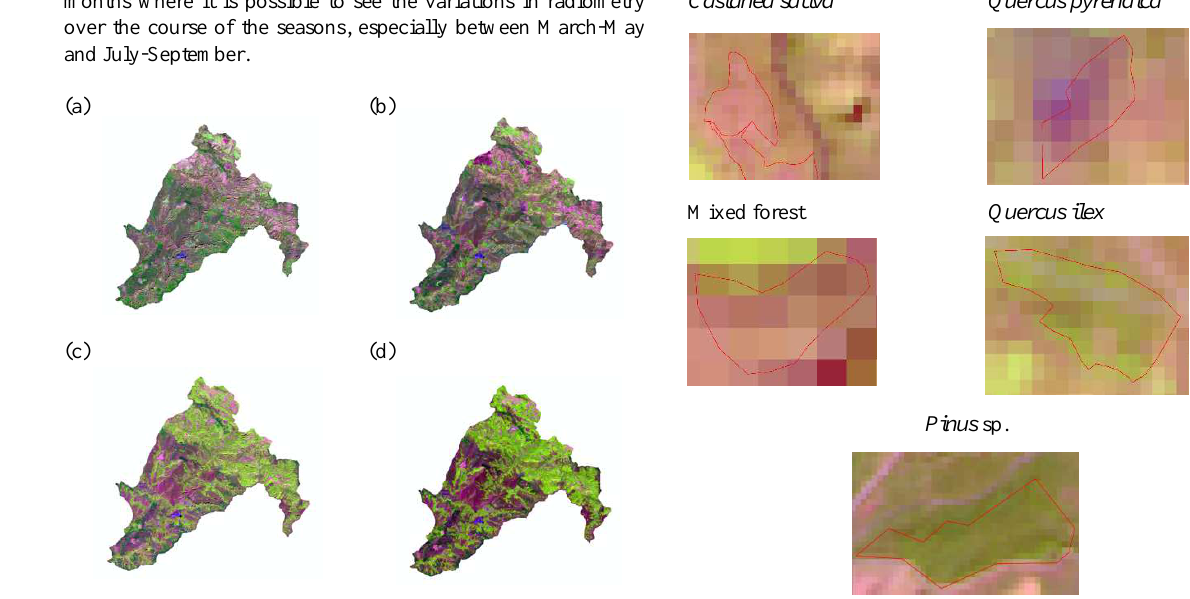
Figure 3. Sentinel 2 bands combination 11/8A/4 for March